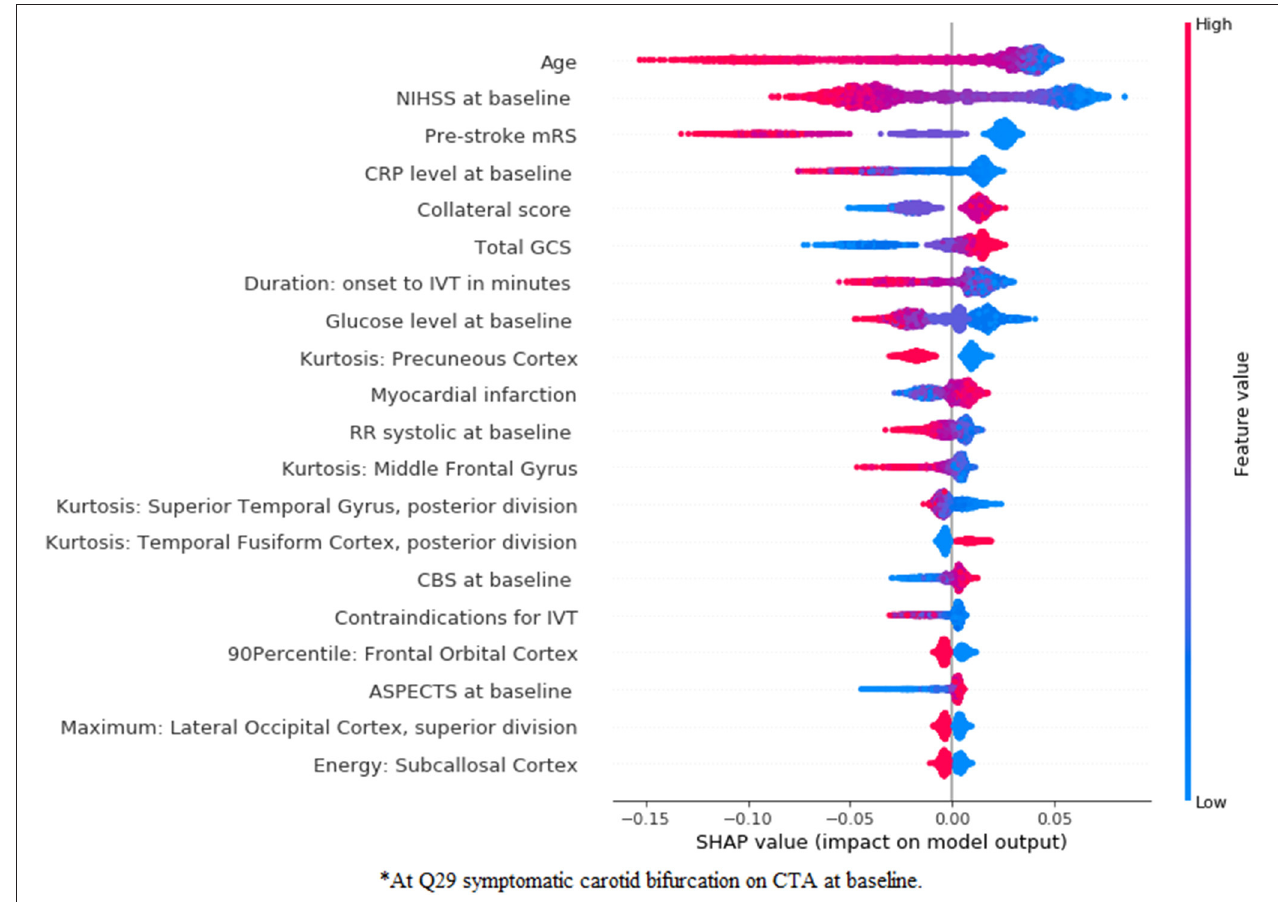
FIGURE 6 | SHapley Additive exPlanations feature importance for the combination experiment for mRS prediction using an RFC model. For visualization purposes, we included only the top 20 features. Features are shown in order of importance, from most important (top) to less important (bottom). The color legend on the right shows how the feature values influence outcome: high values are depicted in red, while low values are presented in blue. Positive SHAP values (above zero in the x -axis) mean that the feature values are associated with the positive outcome (in this case good functional outcome), while SHAP values below zero indicate the opposite. * At symptomatic carotid bifurcation on CTA at